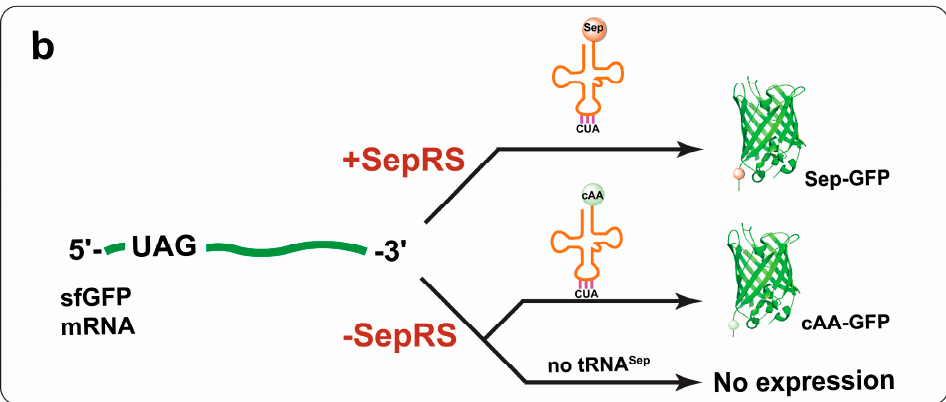
Figure 1. ( a ) Schematic representation of stop codon suppression with noncanonical amino acids (ncAAs). An orthogonal aminoacyl-tRNA synthetase (aaRS) (represented by SepRS) aminoacylates an orthogonal suppressor tRNA (anticodon CUA, shown in orange) with a noncognate amino acid (Sep). Sep-tRNA SepCUA is delivered to the ribosome by the modified version of the host elongation factor EF-Tu. At the ribosome, the Sep-tRNA SepCUA decodes an internal stop codon (UAG) and the ncAA is incorporated in the nascent protein. ( b ) Schematic depiction of a stop codon read-through assay using super-folder green fluorescent protein (sfGFP)-2TAG. A stop codon containing mRNA can be translated only in the presence of suppressor tRNA (here, tRNA SepCUA ). In the presence of SepRS, tRNA SepCUA is aminoacylated with phosphoserine, which is subsequently incorporated into sfGFP. In the absence of SepRS, an endogenous aaRS may misacylate tRNA SepCUA with a canonical amino acid, which then becomes incorporated into sfGFP.